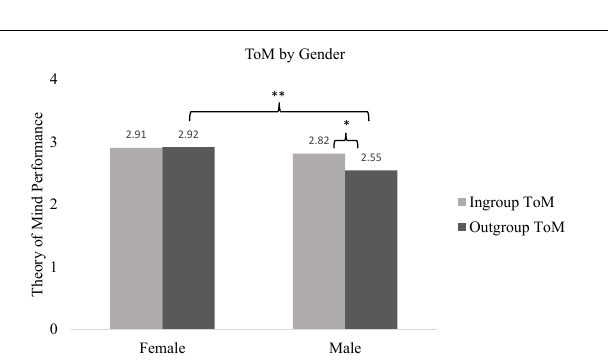
FIGURE 1 | Participants’ ingroup and outgroup ToM by school. ∗ p < 0.05.